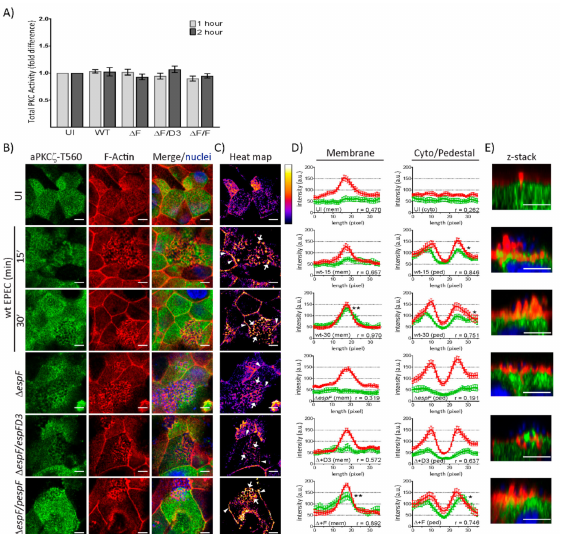
Figure 3. EspF and its SNX9-binding domain contribute to the co-localization of phosphorylated aPKC ζ –T560 and F-actin at the plasma membrane and within pedestals. SKCO-15 monolayers plated on Transwells were infected with wt EPEC or EspF mutant strains, then PKC kinase activity, and F-actin and p-aPKC ζ -T560 co-localization were assessed. ( A ) Fold change in PKC activity does not change at 1 or 2 h post-infection with EPEC (WT), ∆ espF ( ∆ F), ∆ espF complemented with mutant espF ( ∆ F / D3) or wt espF ( ∆ F / F) compared to UI monolayers. ( B – E ) p-aPKC ζ –T560 is recruited to and co-localizes with F-actin at the cell–cell contacts and within pedestals 15 and 30 min post-infection with wt EPEC. p-aPKC ζ –T560 recruitment is reduced following infection with ∆ espF or ∆ espF / pespF D3. Complementation of espF ( ∆ espF / pespF ) restores F-actin and p-aPKC ζ –T560 co-localization levels similar to wt. ( C ) Heat map generated from merged images in B indicating the intensity of F-actin and p-aPKC ζ –T560 co-localization at the plasma membrane (arrowheads) and pedestals (arrows). ( D ) Immunofluorescence (IF) quantification of images represented in B. IF intensity in arbitrary units (a.u.) plotted against length (pixel) of p-aPKC ζ –T560 (green) and F-actin (red) at the membrane and within the cell. Graphs represent data from > 15 regions of interest from three biological replicates. Average peak intensity for p-aPKC ζ –T560 reveals significantly higher levels at the membrane with wt and ∆ espF / pespF at 30 min post-infection and significantly higher levels within pedestals with wt-15, wt-30, and ∆ espF / pespF 30 min post-infection compared to uninfected controls; one-way ANOVA, * p < 0.01 and ** p < 0.001. r = Pearson correlation coe ffi cient indicating an association between F-actin domain dependent manner. ( E ) Z-stack images reveal F-actin and p-aPKC ζ –T560 co-localization within pedestals. Scale bars: 10 µ m (en face); 5 µ m